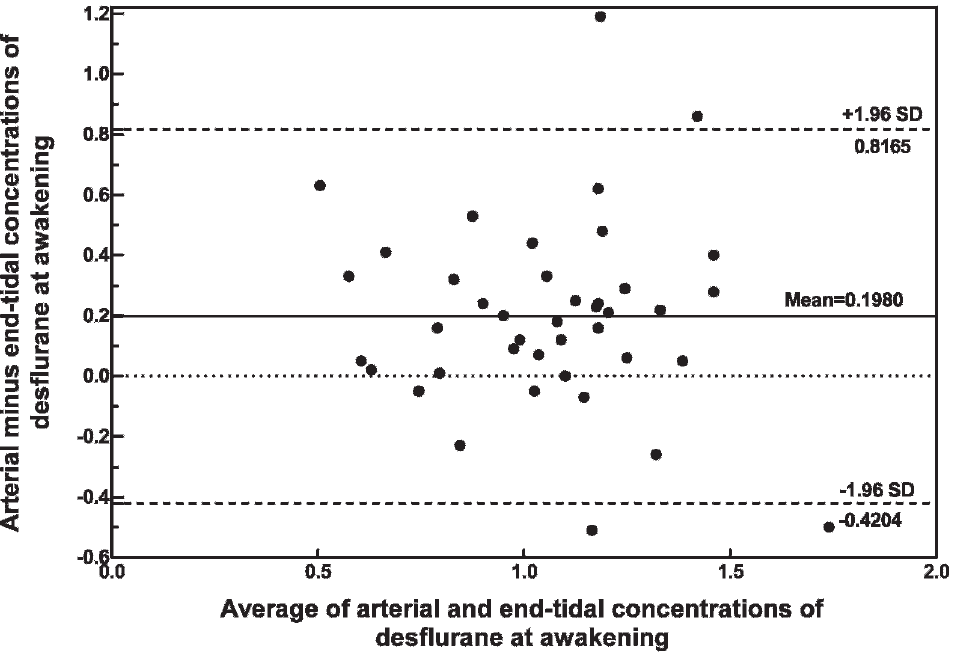
Figure 2 - Bland-Altman plot displaying the difference between the awakening arterial blood and end-tidal concentrations plotted against the average of the two concentrations. The differences were mostly within the ¡ 1.96